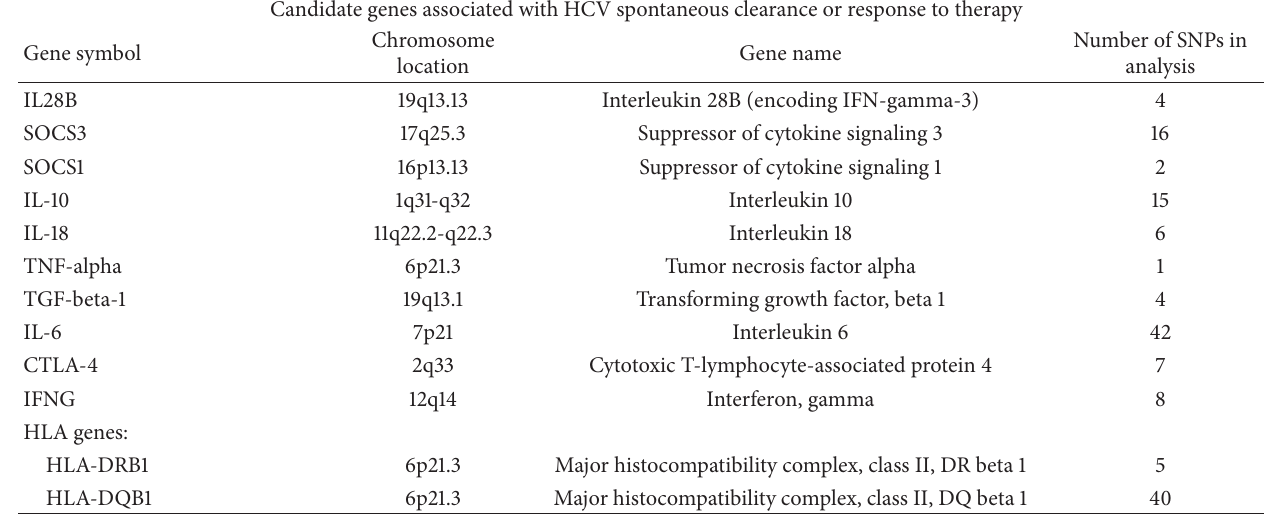
Table 1: Candidate genes